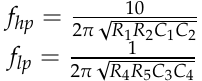
Figure 3. Typical ECG data acquisition block diagram using discrete components.